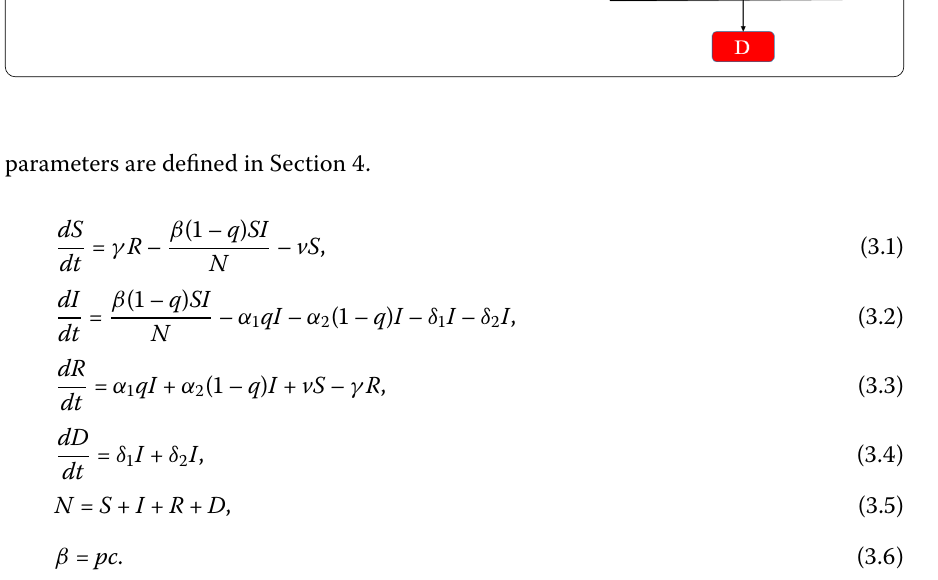
Figure 1 Compartmental flow of a mathematical model for Ebola epidemics.